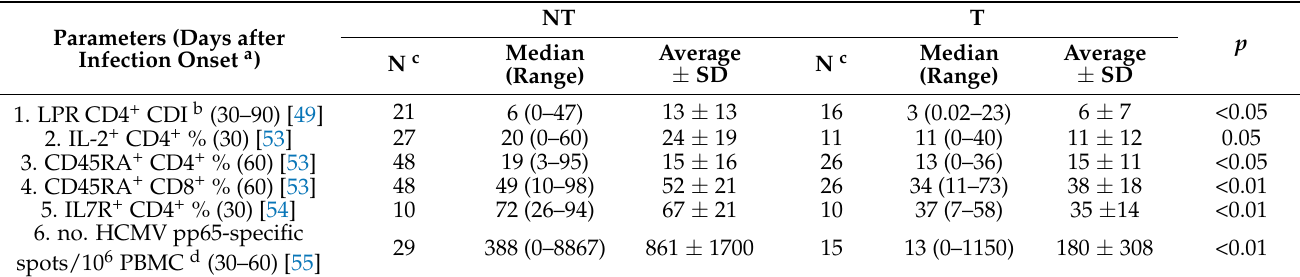
Table 1. Immune correlates of protection against HCMV transmission to the fetus in groups of non-transmitting (NT) and transmitting (T) pregnant women with PI. Parameters (Days after Infection Onset a